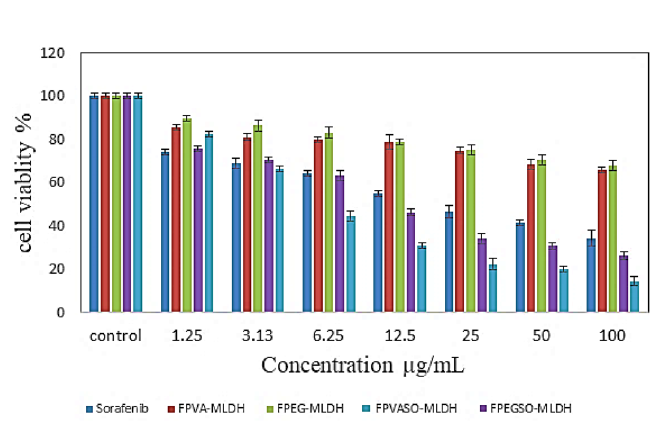
Figure 14. Cytotoxicity assay of sorafenib (SO), FPEG-MLDH, FPVA-MLDH, FPEGSO-MLDH and FPVASO- MLDH against HepG2 cells at 72 h of incubation. Results were calculated as mean ± standard deviation for n = 3 independent experiments. * p < 0.05 compared to control (untreated cells) and treatment group using the ANOVA and Duncan’s Multiple Range